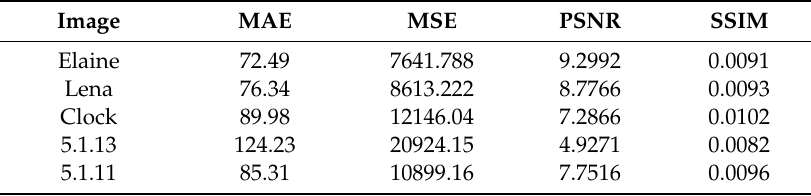
Table 6. MAE, MSE, and PSNR values of sample cipher